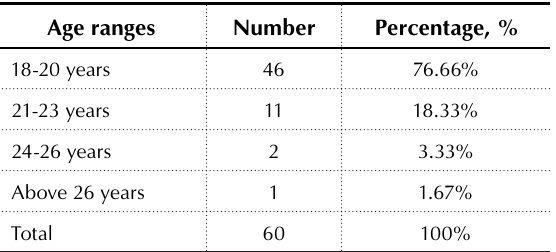
Table 2. Age frequency of